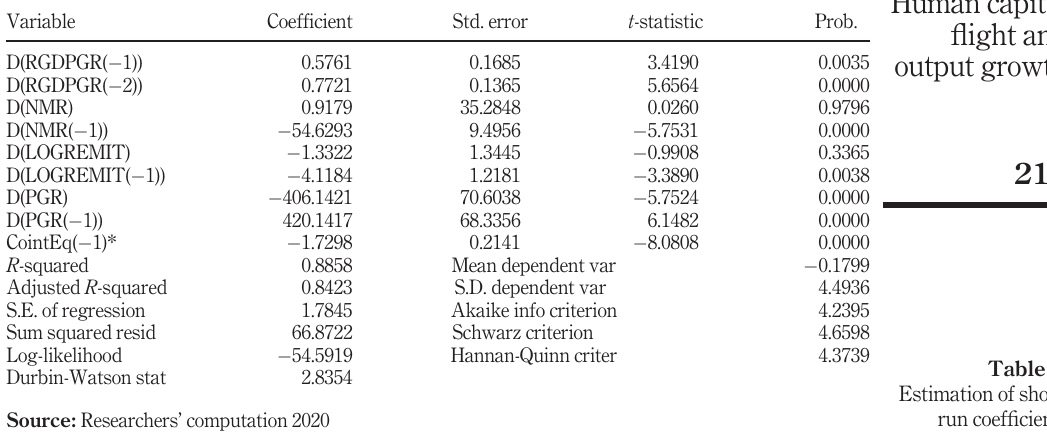
Table 5. Estimation of short-